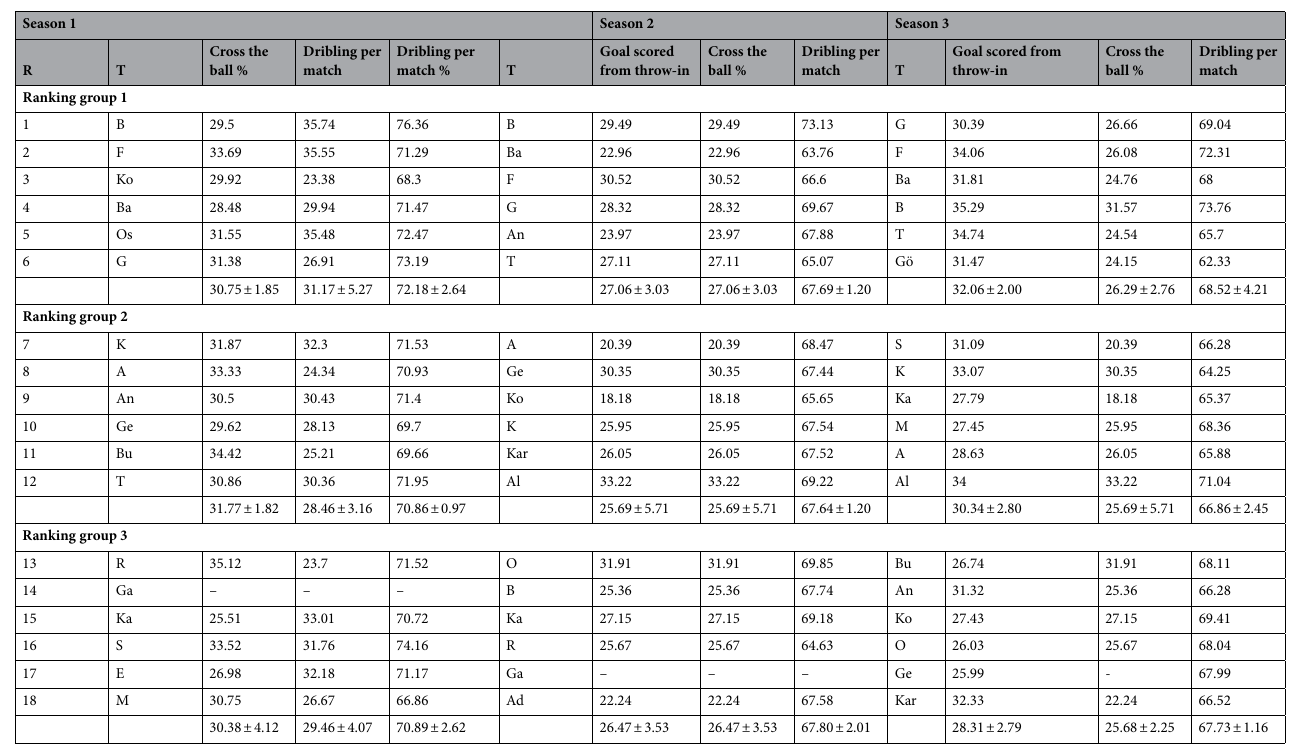
Table 6. Technical data of the player during the match [Cross the ball%. Dribbling per match and Dribbling per match % (mean and SE)] as a function of Ranking group and Season Condition. R: Ranking; Teams: Beşiktaş (B); Fenerbahçe (F); Konyasport (Ko); Başakşehir (Ba); Osmanlıspor (O); Galatasaray (G); Kasımpaşa (K); Akhisar (A); Antalyaspor (An); Gençlerbirliği (Ge); Bursaspor (Bu); Trabzonspor (T); Rizespor (R); Gaziantepspor (Ga); Kayserispor (Ka); Sivasspor (S); Eskişehirspor (E); Mersin İY (M); Karabükspor (Kar); Alanyaspor (Al); Adanaspor (Ad). Göztepe (Gö). and Malatyaspor